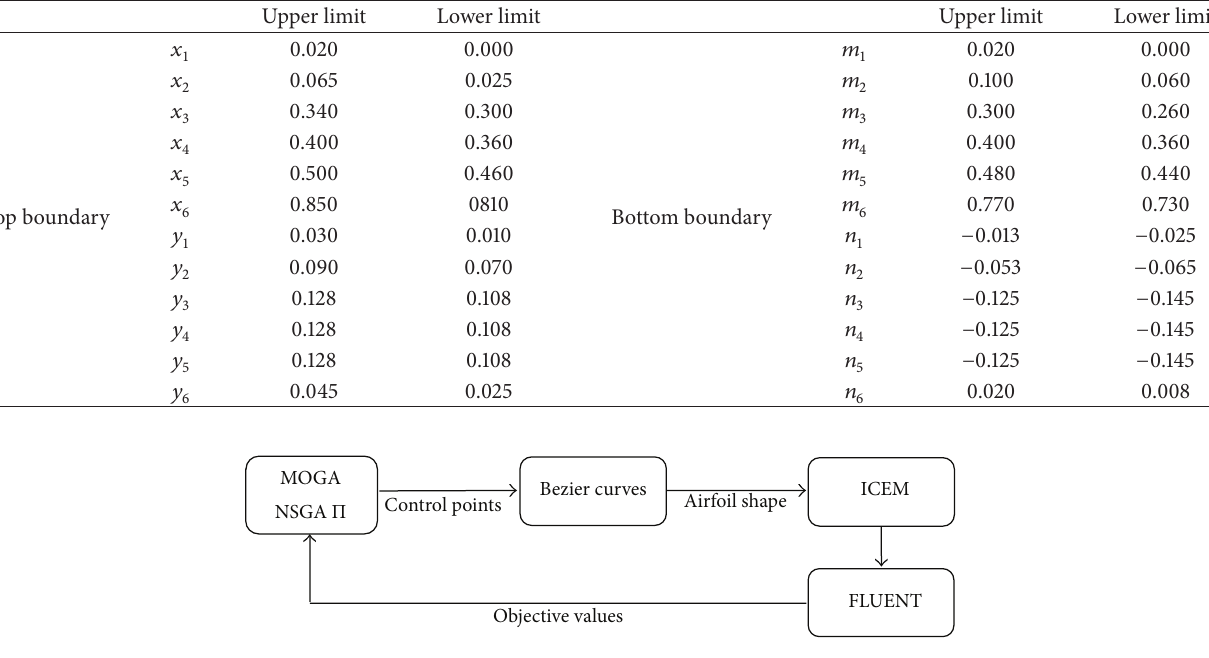
Figure 2: Schematic of information flow in the optimization process.